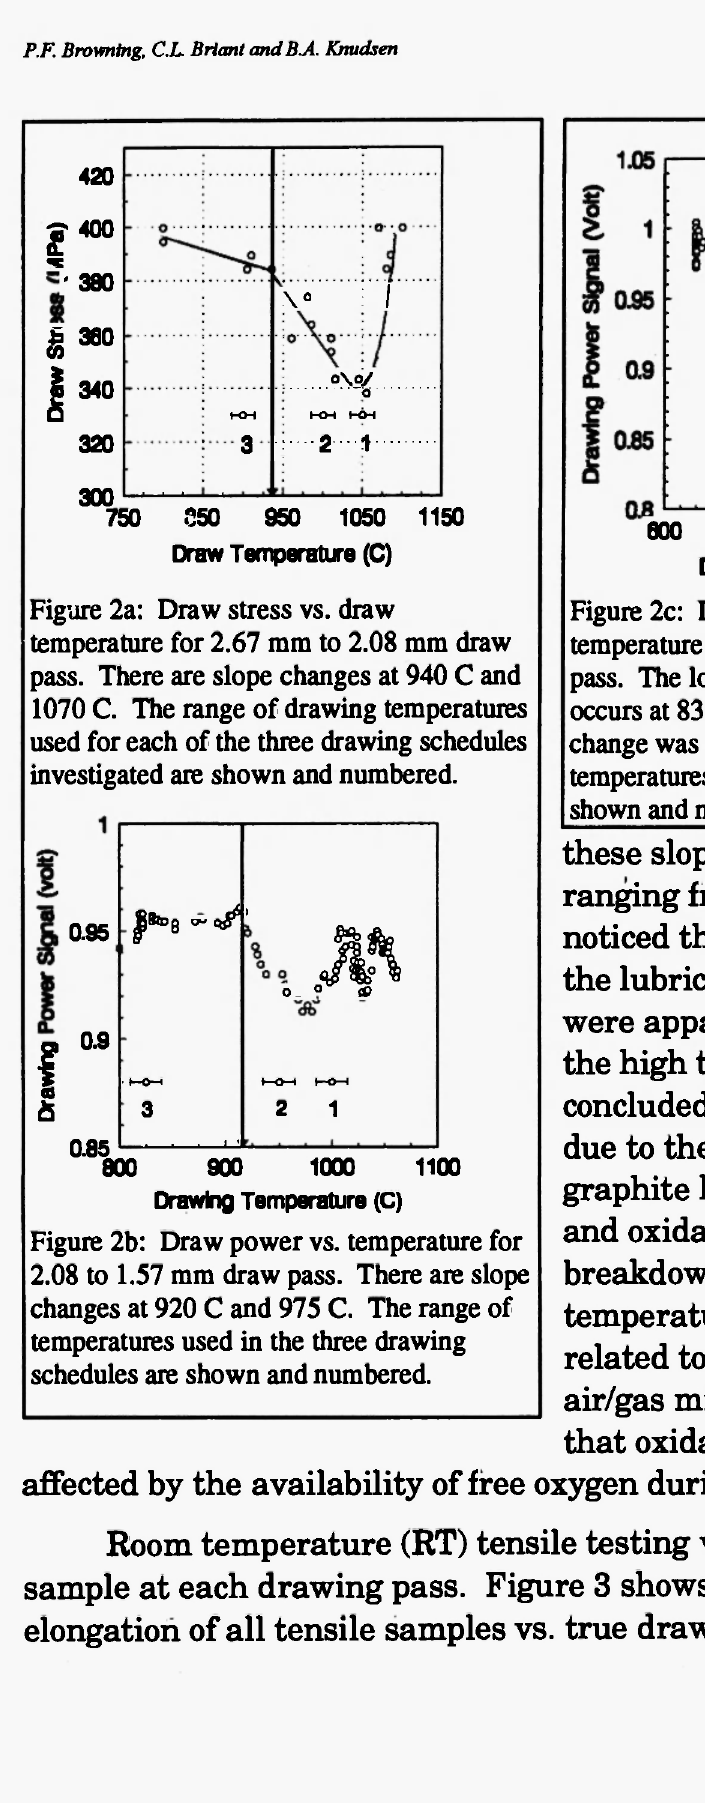
Figure 2a: Draw stress vs. draw temperature for 2.67 mm to 2.08 mm draw pass. There are slope changes at 940 C and 1070 C. The range of drawing temperatures used for each of the three drawing schedules investigated are shown and numbered.